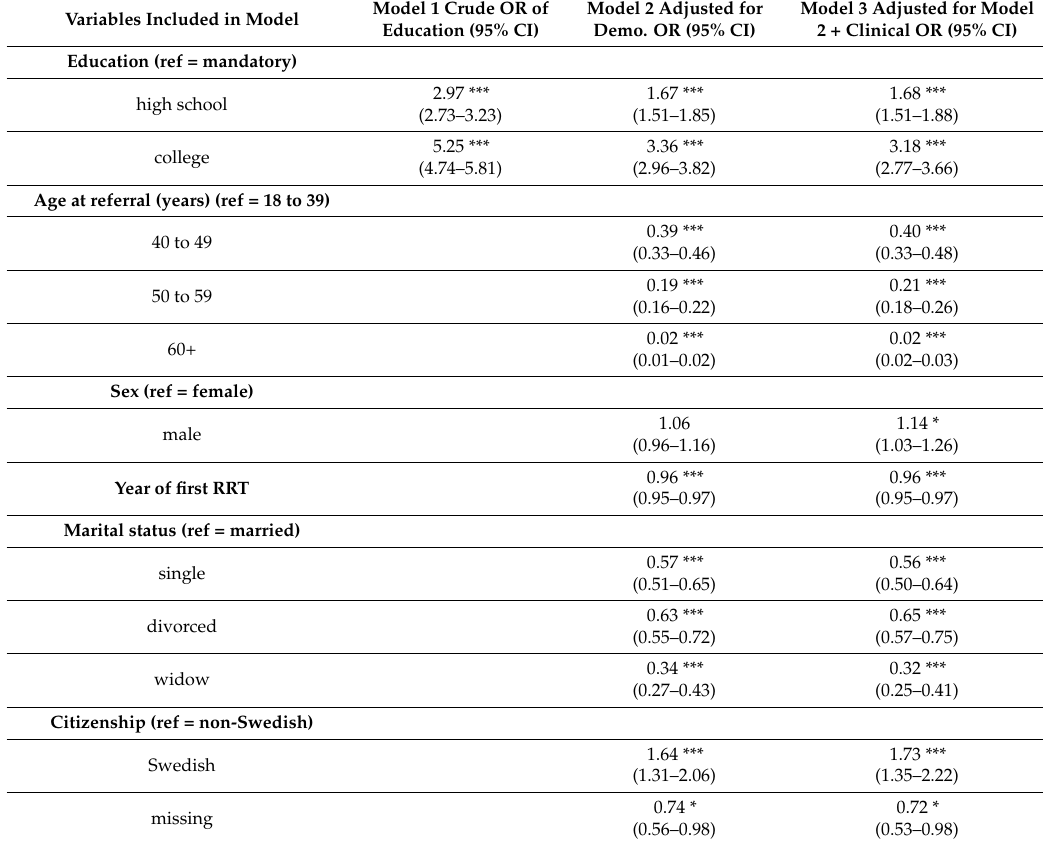
Table 3. The association between education and access to kidney transplantation by the multivariate logistic